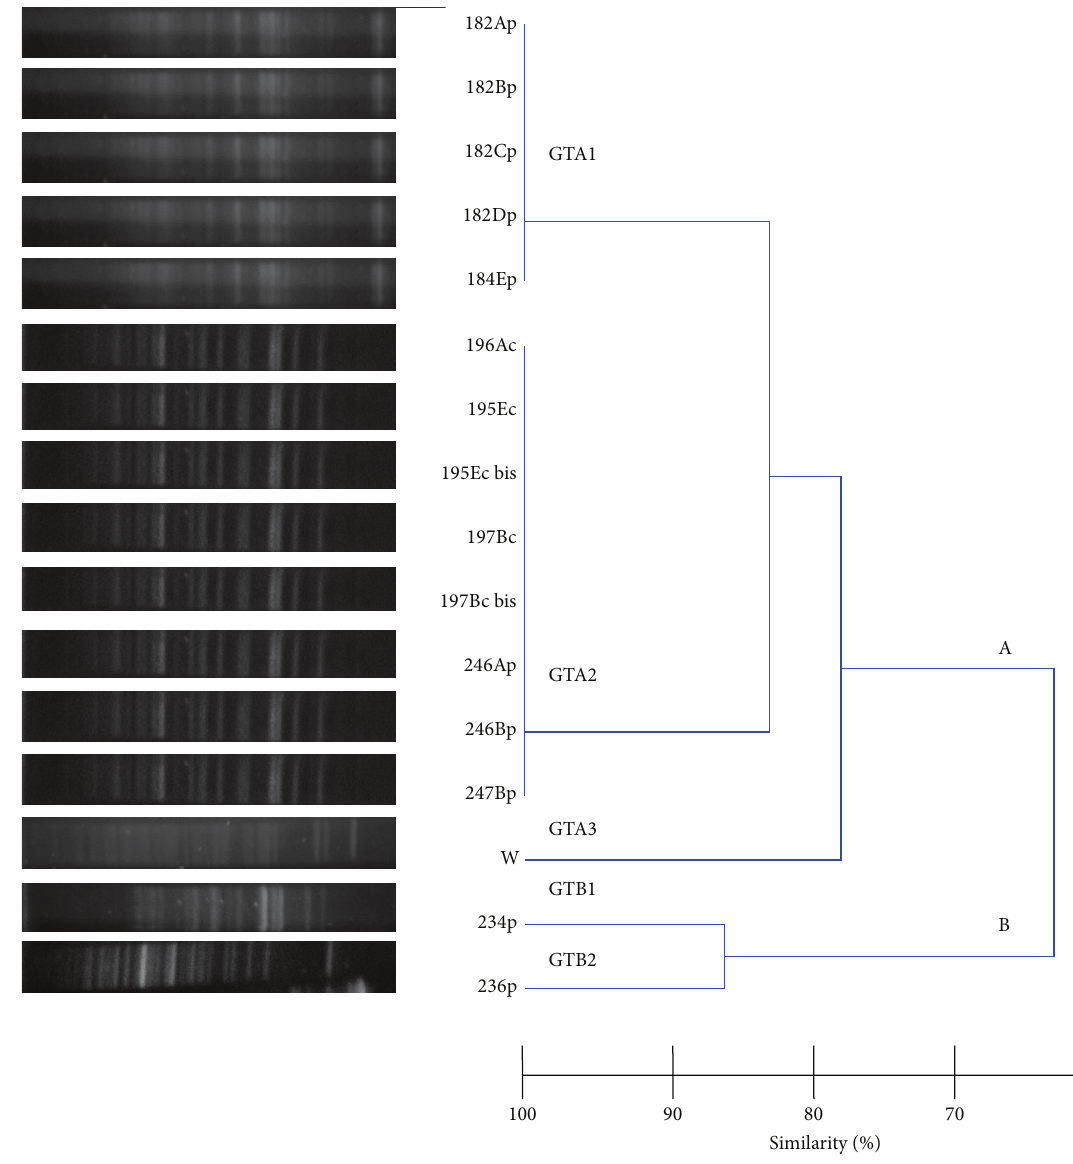
Figure 2: Fingerprints and dendrogram obtained by PFGE of fifteen Yersinia isolates. GT, genomic type. Y. enterocolitica B1A O:12,25-12,26 (182Ap, 182Bp, 182Cp, 182Dp, 184Ep) isolates from two chicken carcasses; Y. enterocolitica B1A O:7,8-8-8,19 isolates from three (196Ac, 195Ec, 195Ec bis, 197Bc, 197Bc bis) porcine skin/bones and two (246Ap, 246Bp, 247Bp) chicken carcasses; Y. enterocolitica W1024 reference strain (W); Y. intermedia B6 O:17 (234p) and Y. intermedia B4 O:40